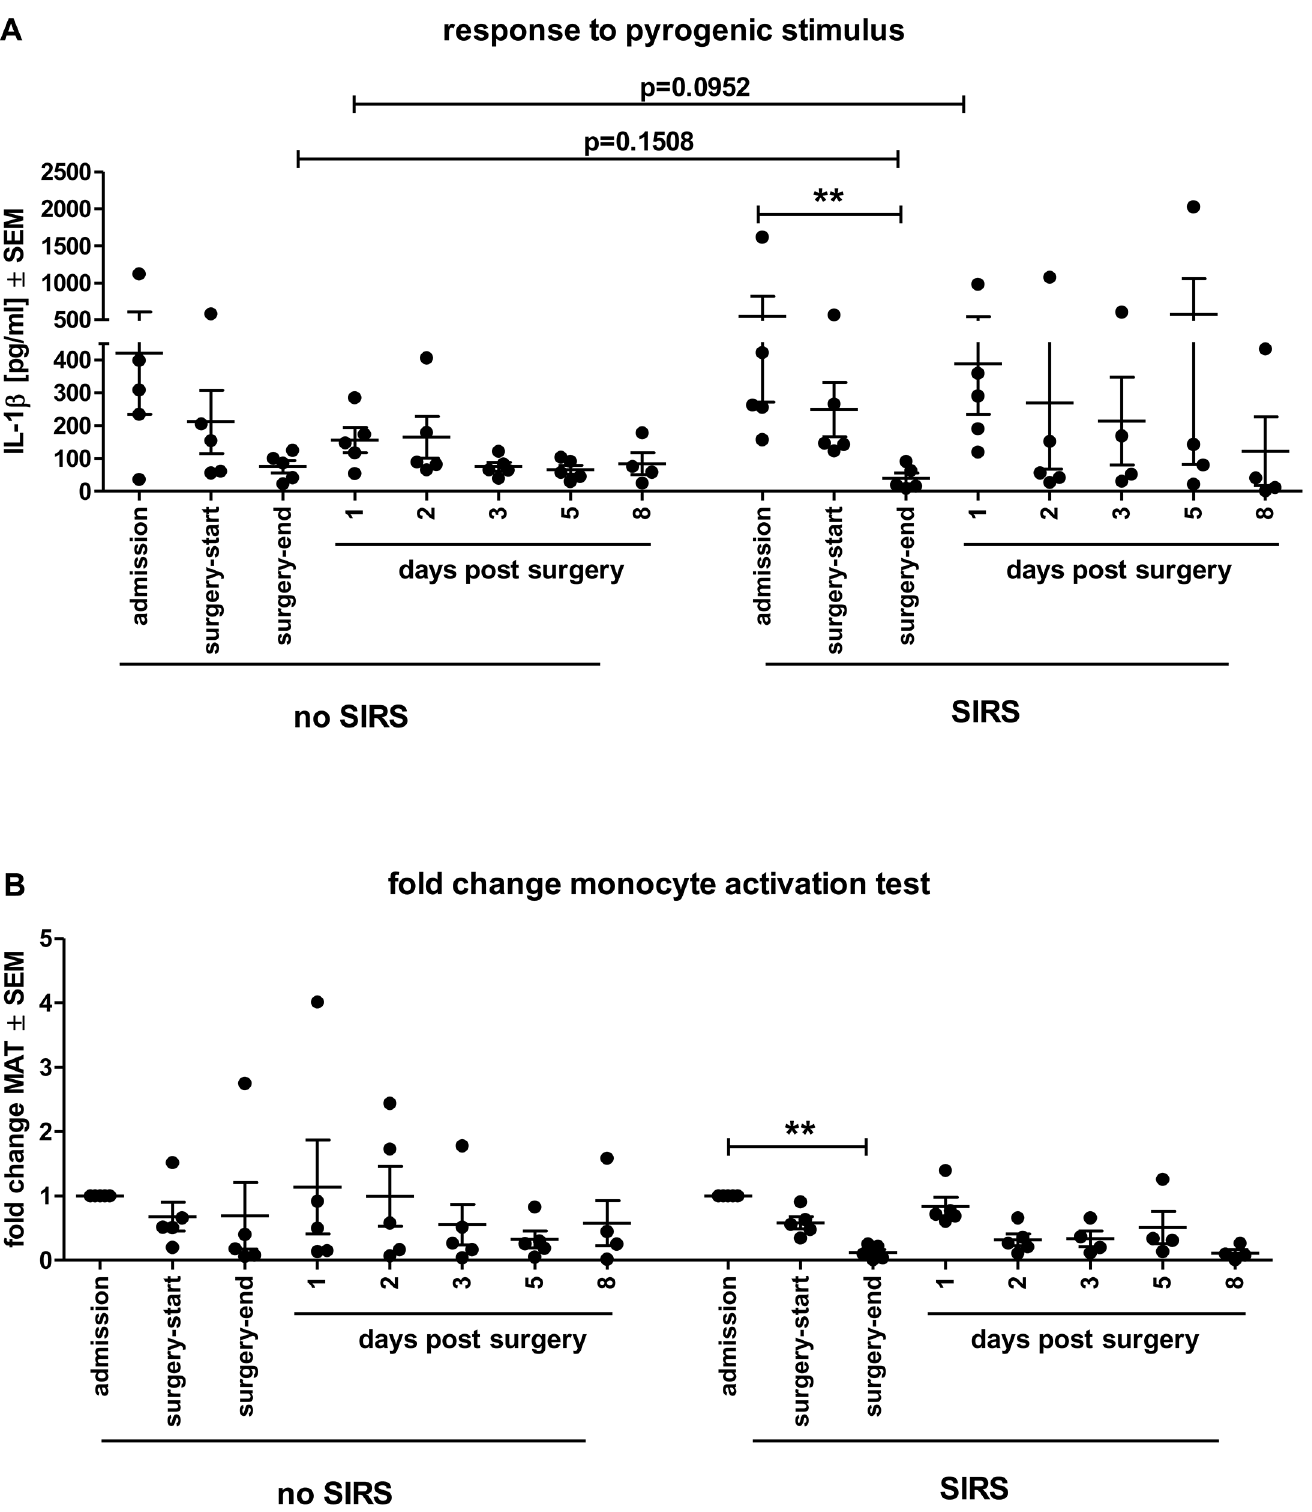
Fig 4. Monocyte activation test (MAT) revealed reduced responsiveness in SIRS patients. Cryopreserved blood of each patient at individual time points was stimulated with reference endotoxin (0.5 EU/ml) corresponding to 0.04 EU/ml in the actual incubation for 8 h at 37°C 5% CO 2 . (A) Individual stimulation responses (shown as IL1 β concentrations ± SEM) of diluted cryopreserved patient blood to an LPS stimulus show a tendency towards decreased responses